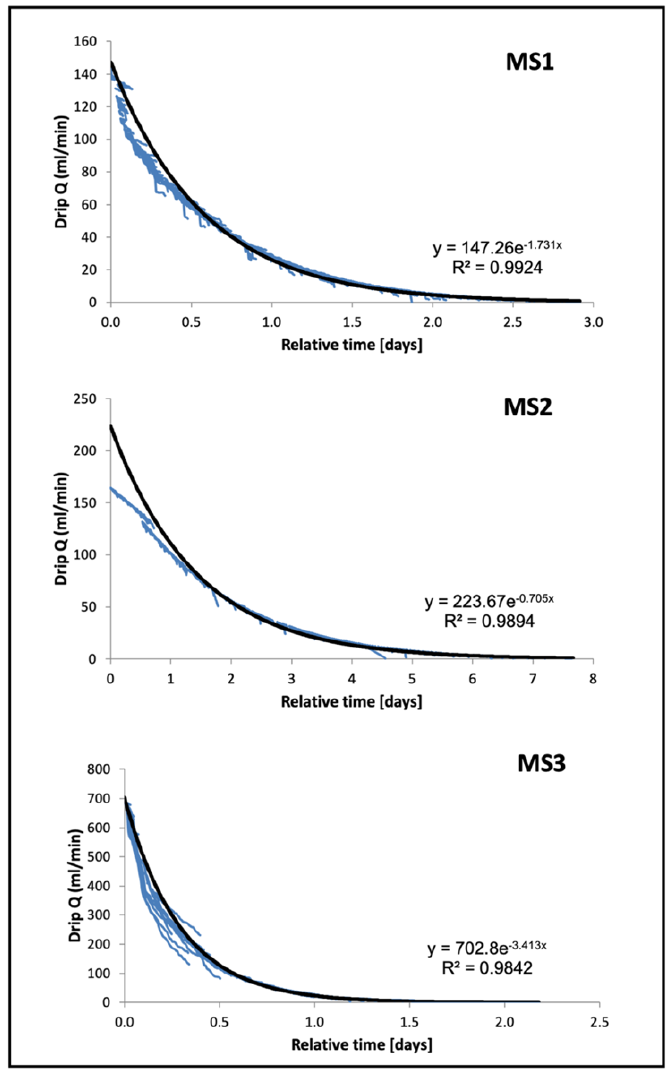
Figure 4. Master recession curve (MRC) fit to each drip site, produced using MRC Generation Excel spreadsheet [51]. Drip data are shown in blue; MRC fit shown in red.